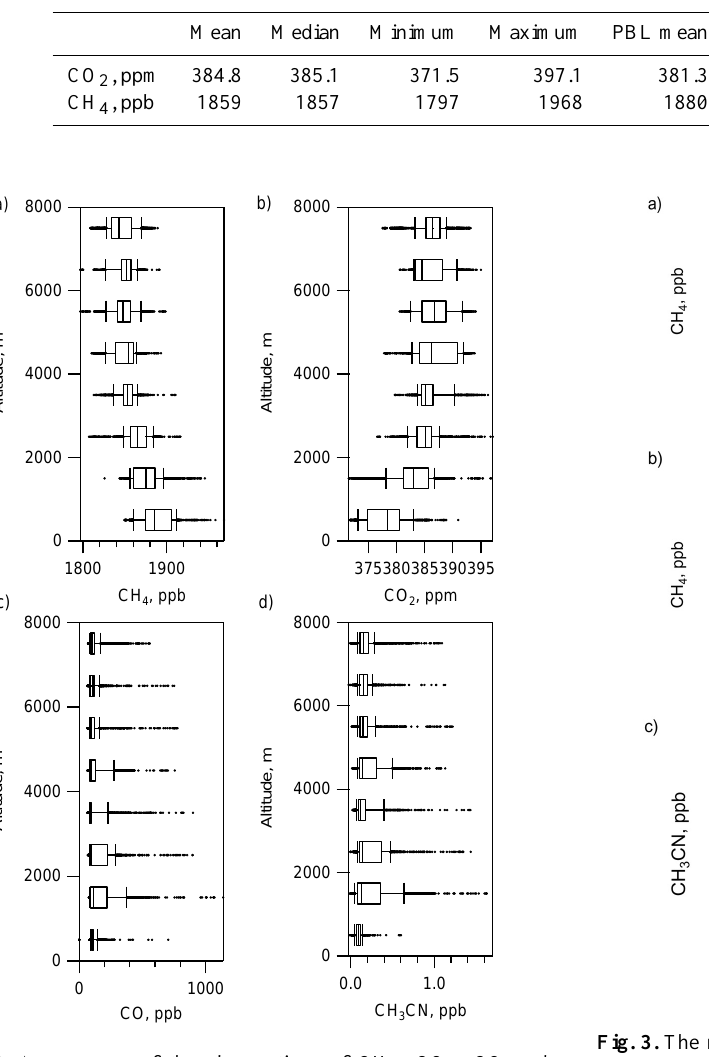
Fig. 2. A summary of the observations of CH 4 , CO 2 , CO and CH 3 CN made on the FAAM BAe-146 during the BORTAS project. The transits from Cranfield, UK, to Nova Scotia, Canada, and the return journey have been excluded from these plots. Boxes are 25th and 75th percentiles, whiskers are 10th and 90th percentiles and the markers are outliers.